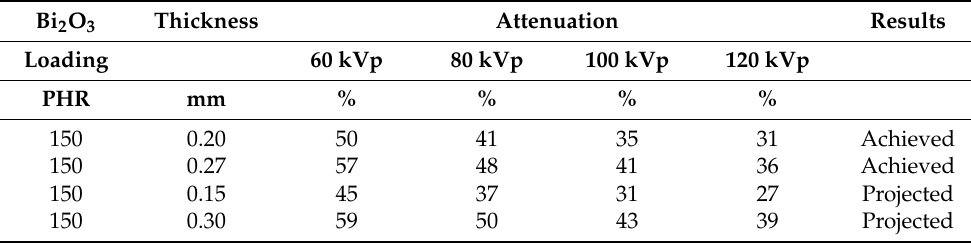
Table 6. Achieved and projected attenuation for films at 150 PHR Bi 2 O 3 loadings and different